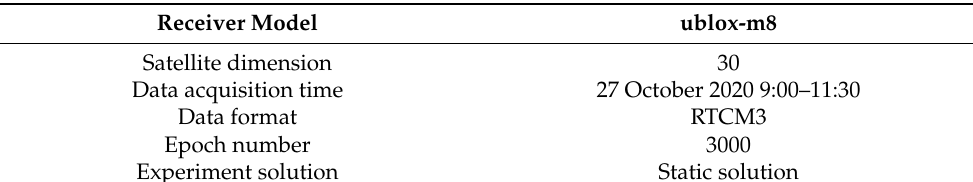
Table 1. Basic information of the experiment.